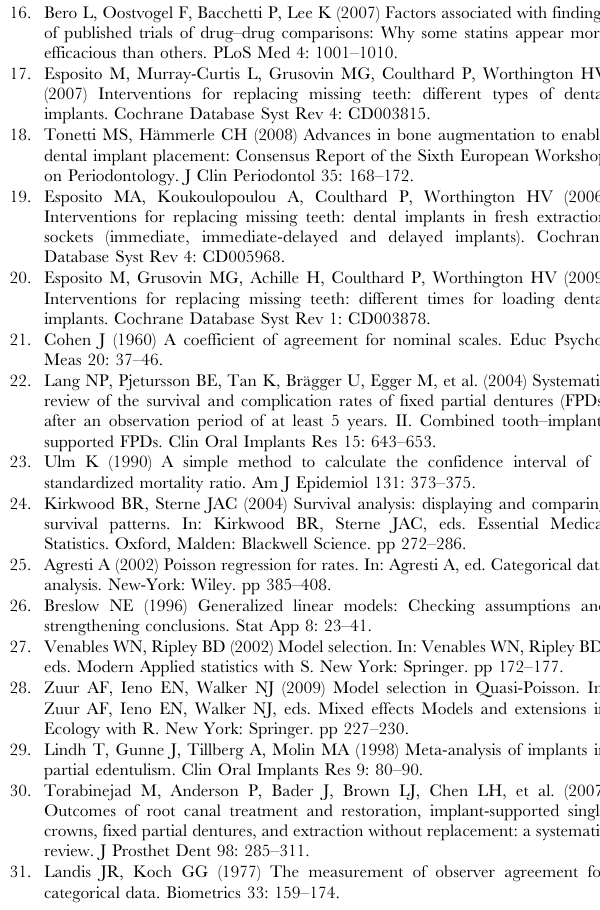
Table S3 List of included